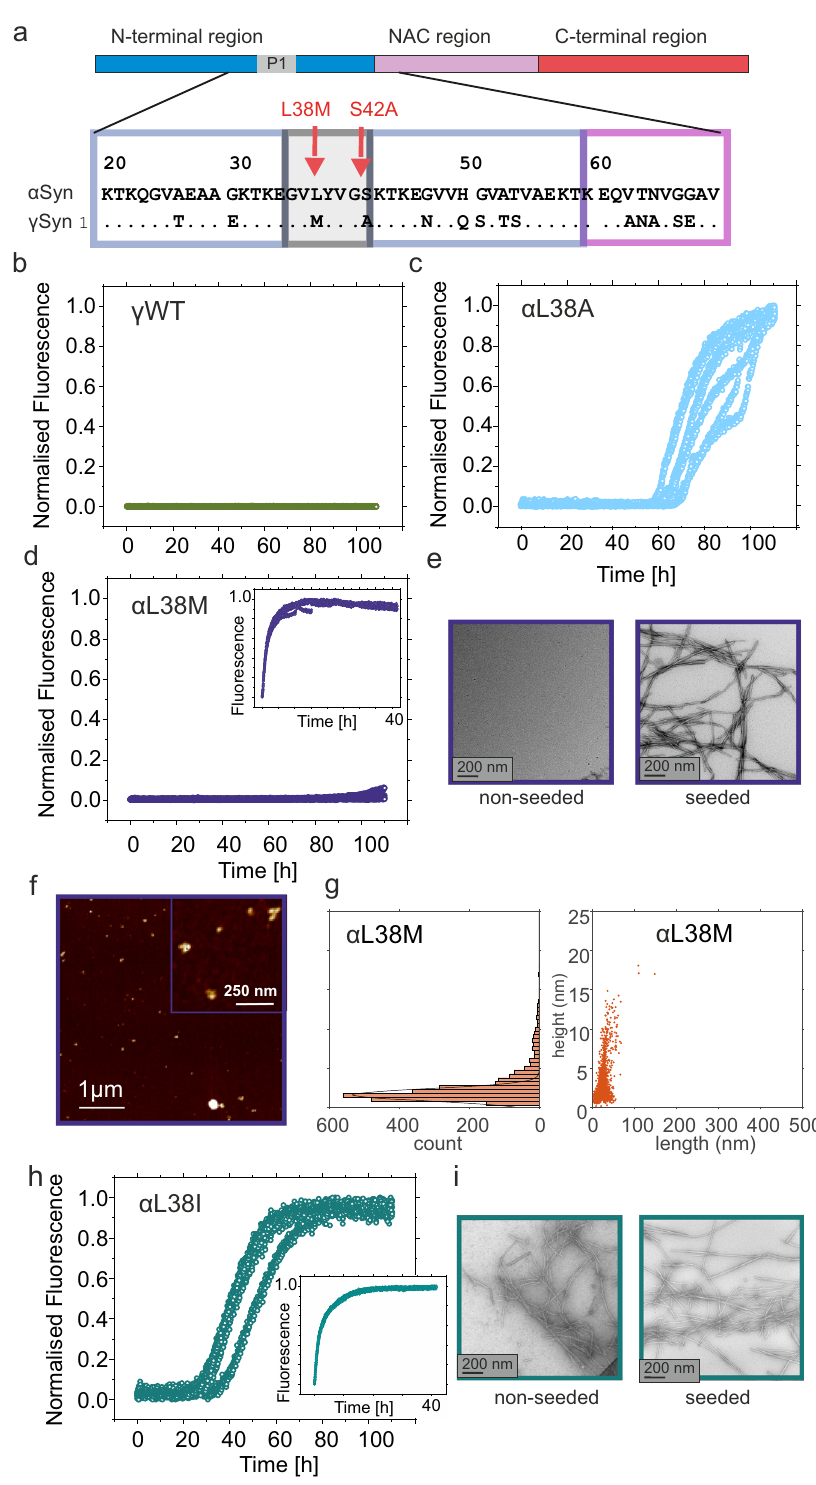
Fig. 6 | α Syn aggregation rate is dependent on the identity of residue 38. a Sequence alignment showing that the P1 regions of α Syn and γ Syn differ at two positions, residues 38 and 42. Aggregation kinetics of b γ Syn, c α Syn L38A (reproducedforclarityfromFig.5b),and d α SynL38M.Theinsetshowsseedingof L38M with 10% ( w/w ) preformed WT α Syn seeds. e TEM images of α Syn L38M incubatedintheabsence(lefthandside)orpresence(righthandside)of10%( w/w ) preformed seeds of WT α Syn. f , g AFM image and height/length distribution ana- lysis( n =2167objectsanalysedinoneimage)oftheproductsofincubationofL38M Supplementary Table 1d. Source data are provided as a Source Data fi